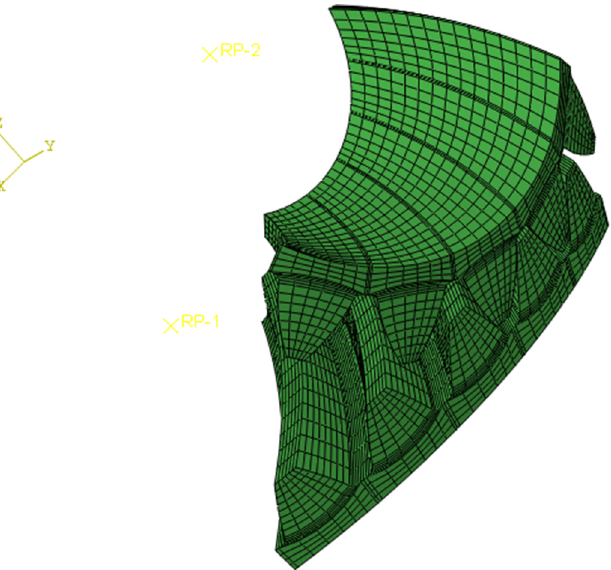
Fig. 8. Model of fi nite element analysis.